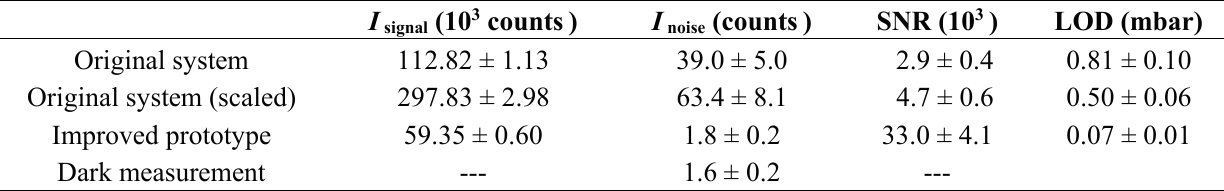
Table 4. Comparison of the original system and the new prototype with all fluorescence-reducing improvements